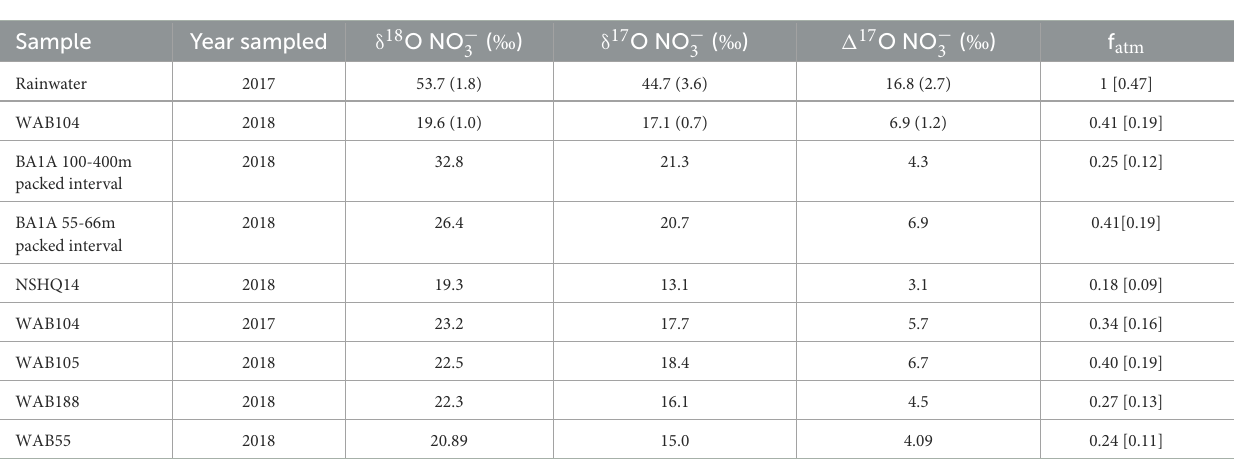
TABLE 6 δ 17 O and δ 18 O isotopic compositions of NO − 3